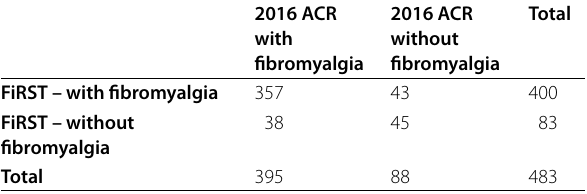
Table 3 Agreement between FiRST and 2016 American College